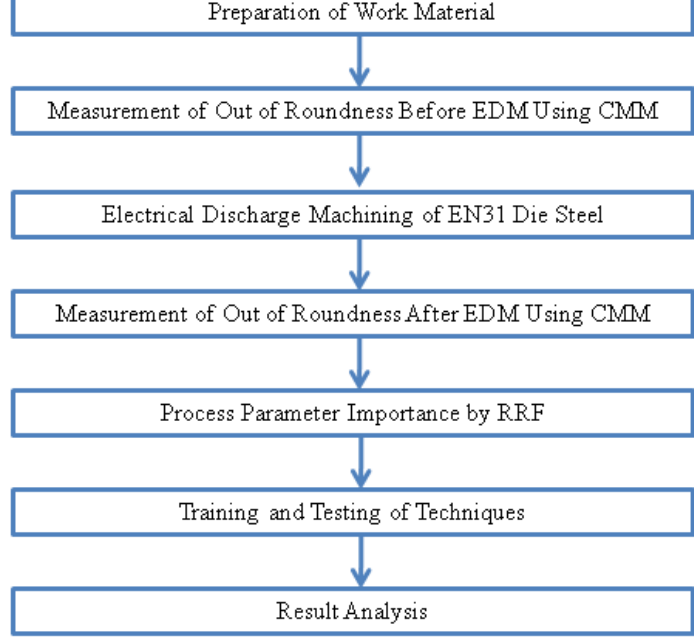
5 3. Performance Evaluation of Machine Learning Techniques The performance of a technique can be evaluated through different criteria and the suitability of a given technique depends upon its specific application. In the present study, the correlation (r), coefficient of determination ( R 2 ), mean absolute error (MAE), accuracy, and K-fold cross-validation were selected for the assessment of the applied techniques. These criteria were preferred based on a previously conducted review of the literature [44]. These evaluation criteria are briefly discussed below. Correlation (r) is a statistical technique that shows the relationship between actual and predicted values. The correlation coefficient lies between +1 and −1 , where values